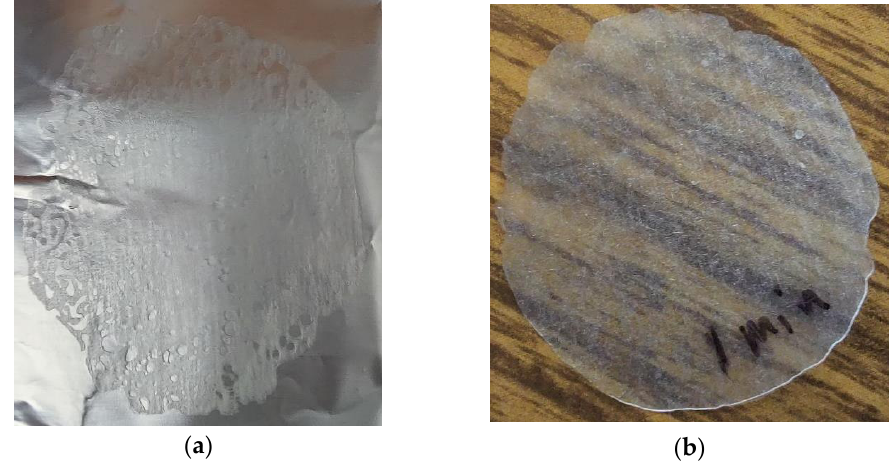
Figure 16. PLA resin beads compressed under 6228 N at 193 ◦ C for 1 min. ( a ) 114 kGy–visible pores at the edge; ( b ) 33 kGy – no visible pores.